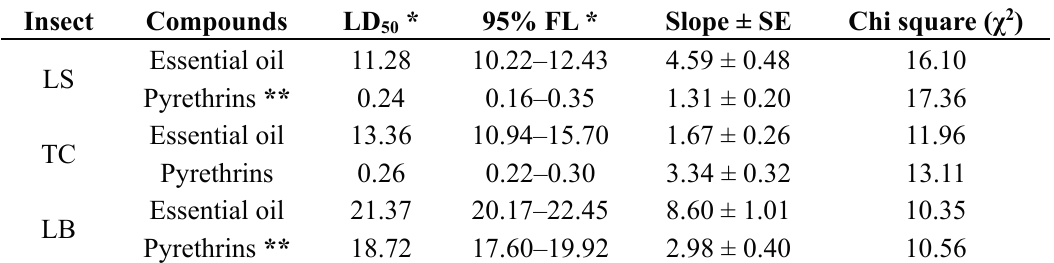
Table 2. Contact toxicity of Liriope muscari essential oil against Tribolium castaneum (TC), Lasioderma serricorne (LS) and Liposcelis bostrychophila (LB) adults.